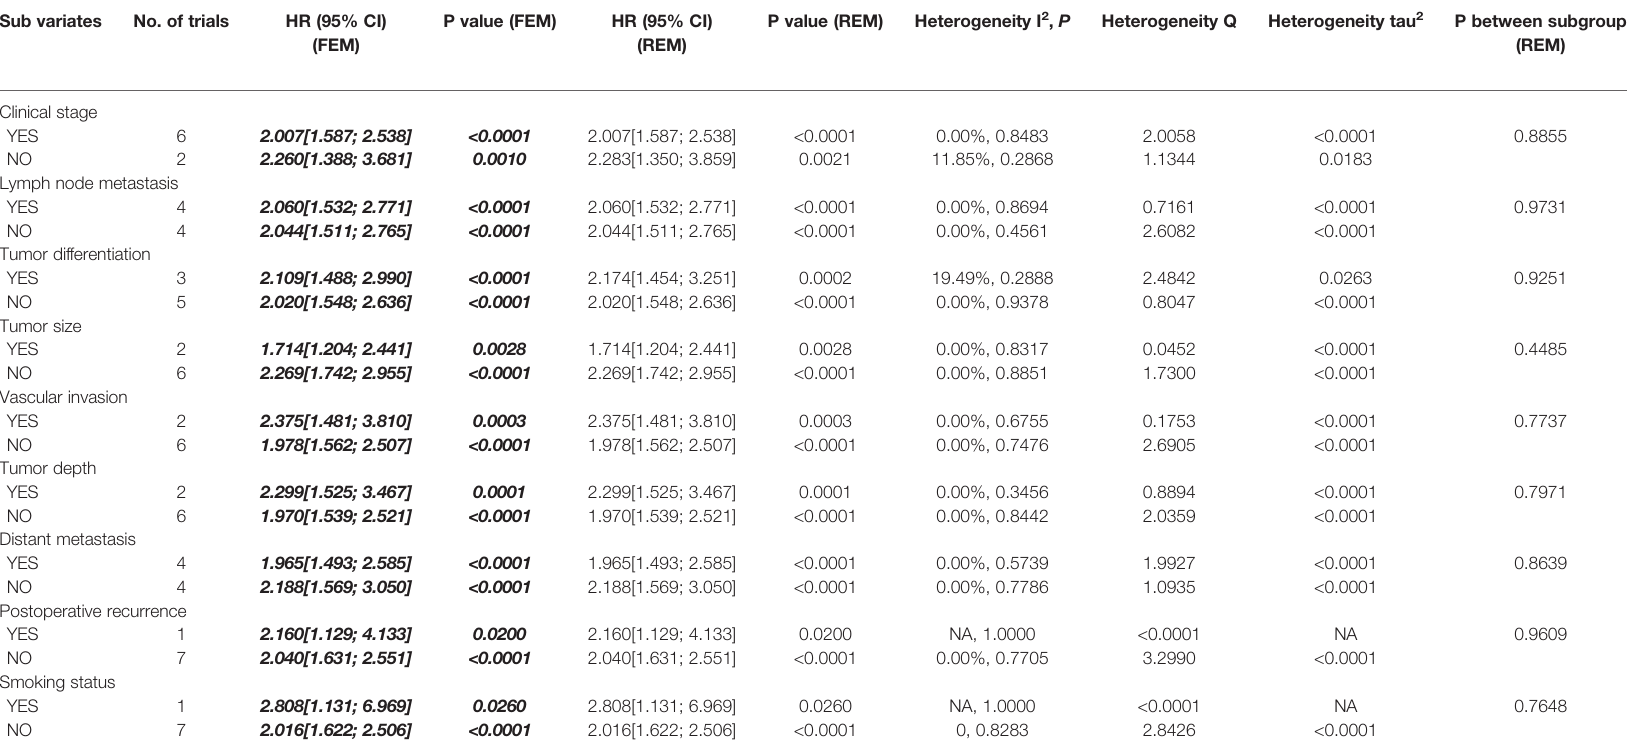
TABLE 5 | Subgroup analyses of the OS in the eight included studies based on adjusted variables. Sub